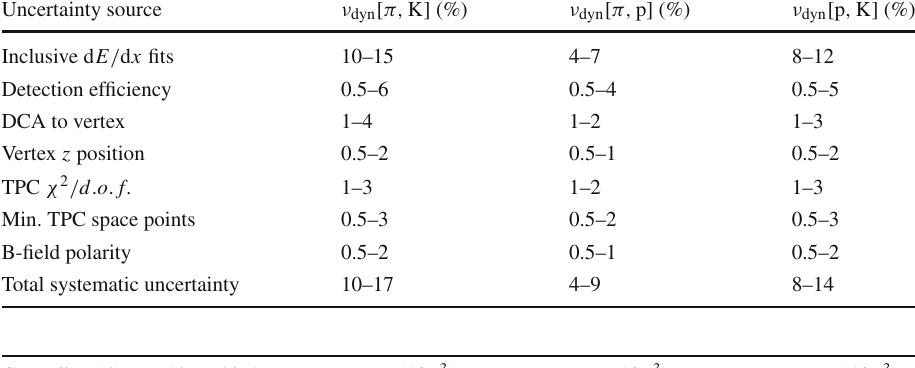
Table 2 Numerical values of ν dyn results for different particle pairs. The first uncertainty is statistical and the second